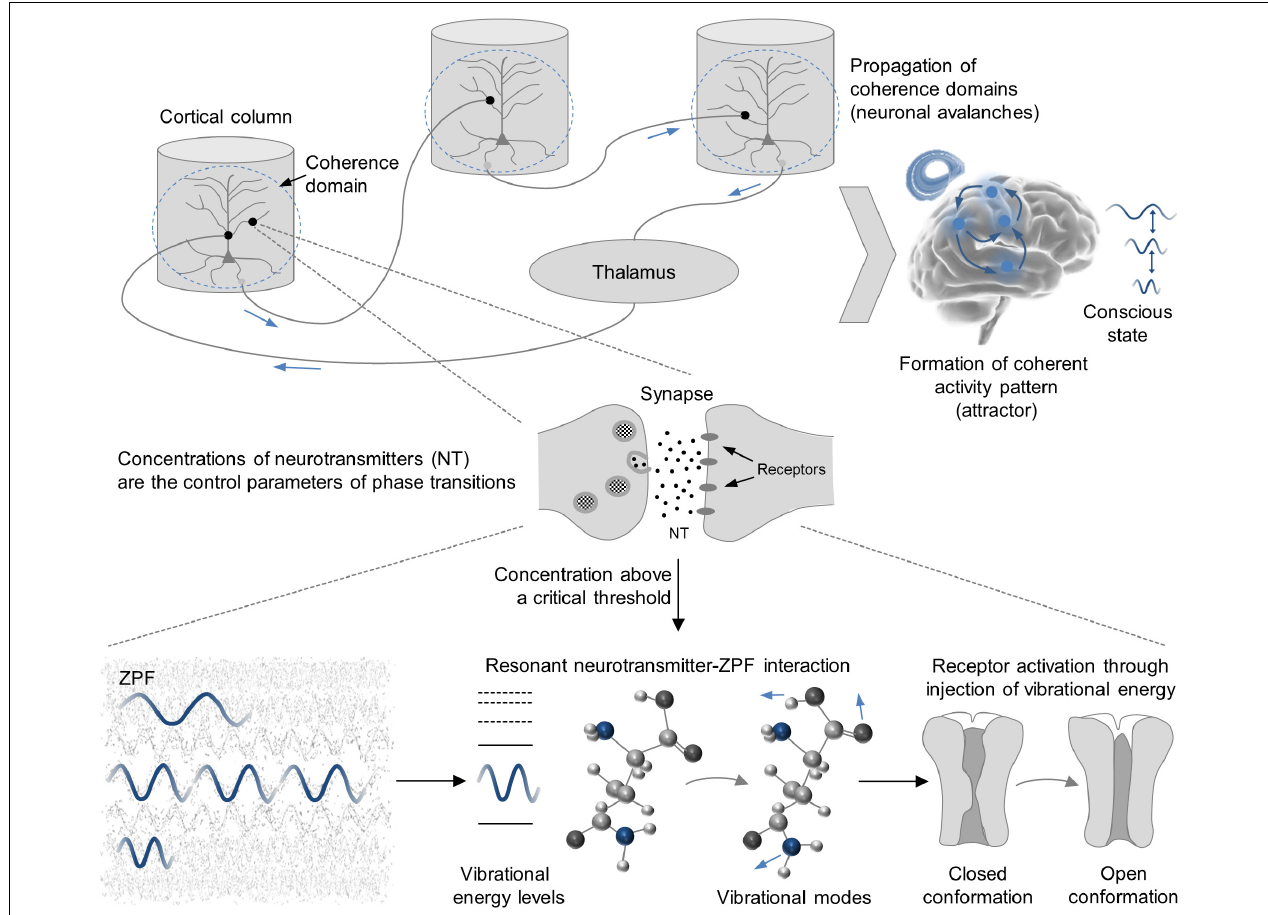
FIGURE 2 | The neurophysiological mechanisms underlying conscious processes. It is postulated that the phase transitions underlying the formation of coherent activity patterns (attractors) are triggered by modulating the concentrations of neurotransmitters. When the concentration of neurotransmitter molecules lies above a critical threshold and selected ZPF modes are in resonance with the characteristic transition frequencies between molecular energy levels, receptor activations ensue that drive the emergence of neuronal avalanches. The set of selected ZPF modes that is involved in the formation and stabilization of an attractor determines the phenomenal properties of the conscious